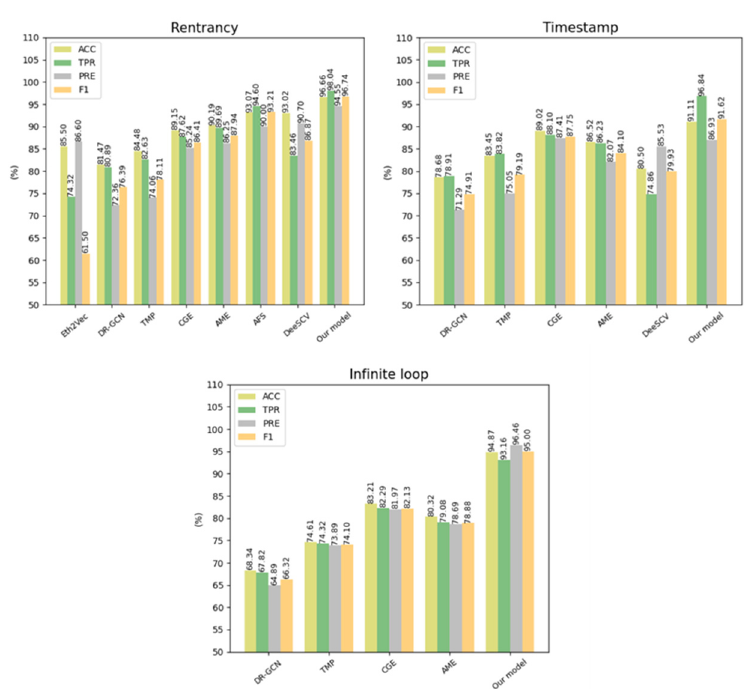
Figure 11. Visualization of images compared to existing deep learning-based methods.